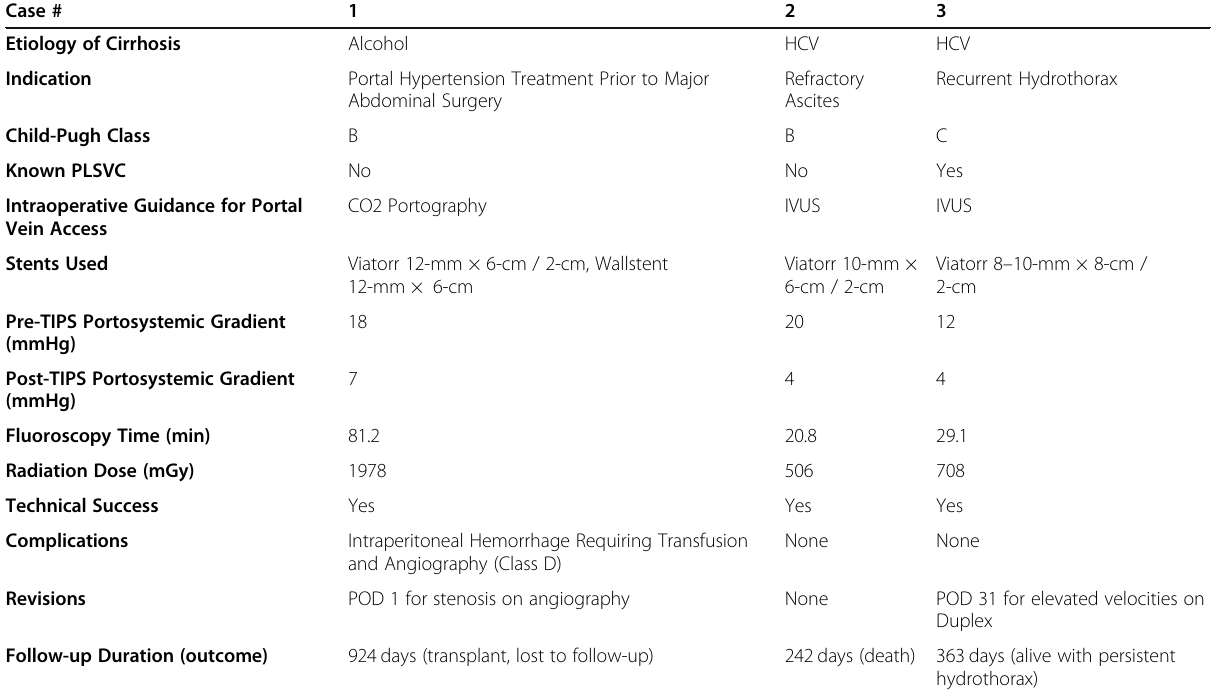
Table 1 Patient demographics, indications, technical details, adverse events, and clinical